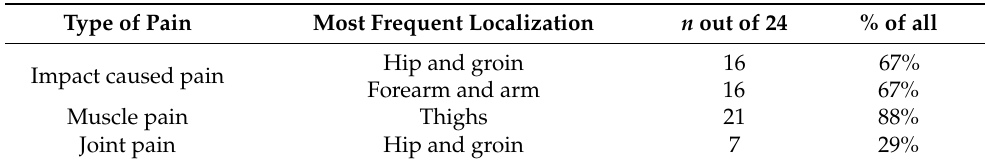
Table 3. Different types of pain in football goalkeepers ( n = 24) following training during preseason training camp (based on Muracki et al., 2019 [61]). Type of Pain Most Frequent Localization n out of 24 % of all Hip and groin 16 67% Impact caused pain Forearm and arm 16 67% Muscle pain Thighs 21 88% Joint pain Hip and groin 7